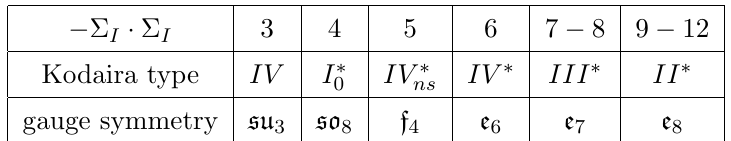
Table 3. Minimal gauge algebras for rational curves with (cid:0) (cid:6) I (cid:1) (cid:6) I (cid:21) 3. For the rational curve with (cid:0) (cid:6) I (cid:1) (cid:6) I = 7 the theory also has matter in the 1